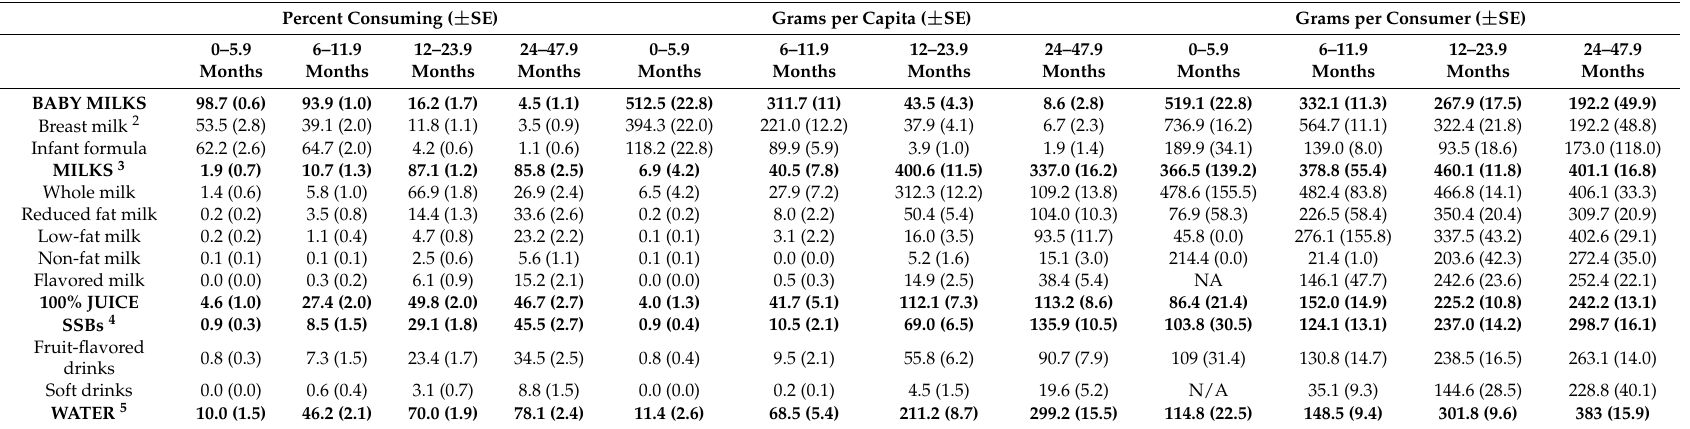
Table 1. Consumption of beverages by age group: mean percent ( ± SE) 1 consuming, mean grams ( ± SE) per capita and mean grams ( ± SE) per consumer among U.S. children, as assessed by 24-h dietary recall and stratified by age group, participating in the Feeding Infants and Toddlers Study, 2016 ( n =